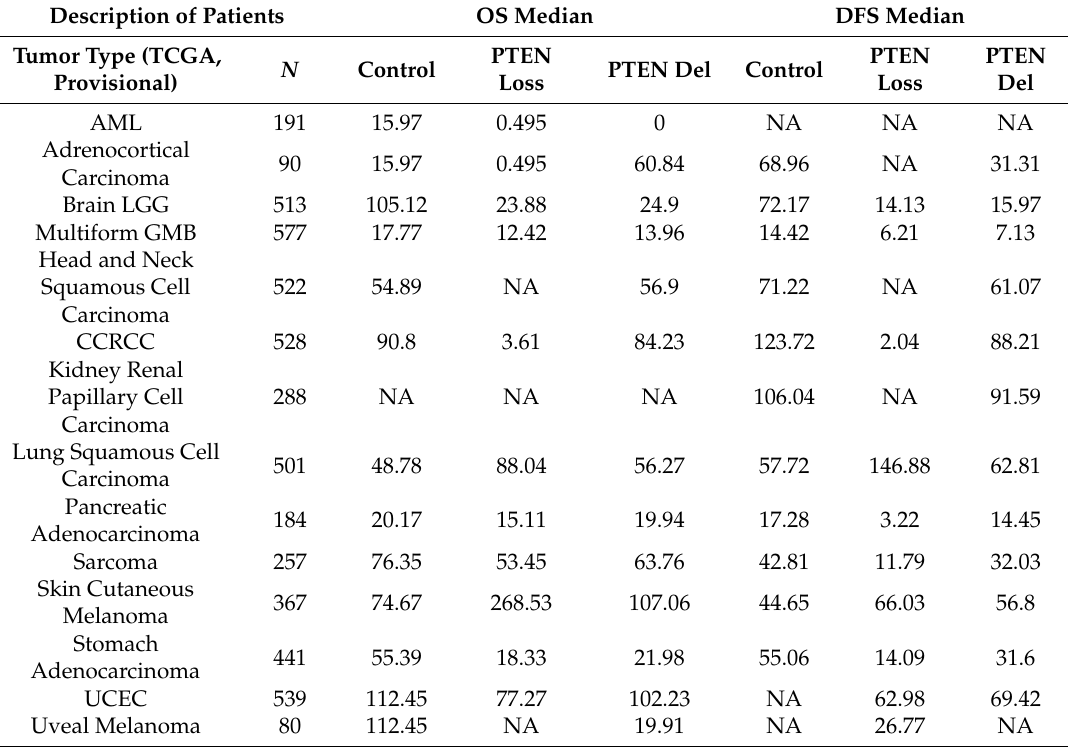
Table 3. Representative survival values for PTEN loss/del partitioning in TCGA